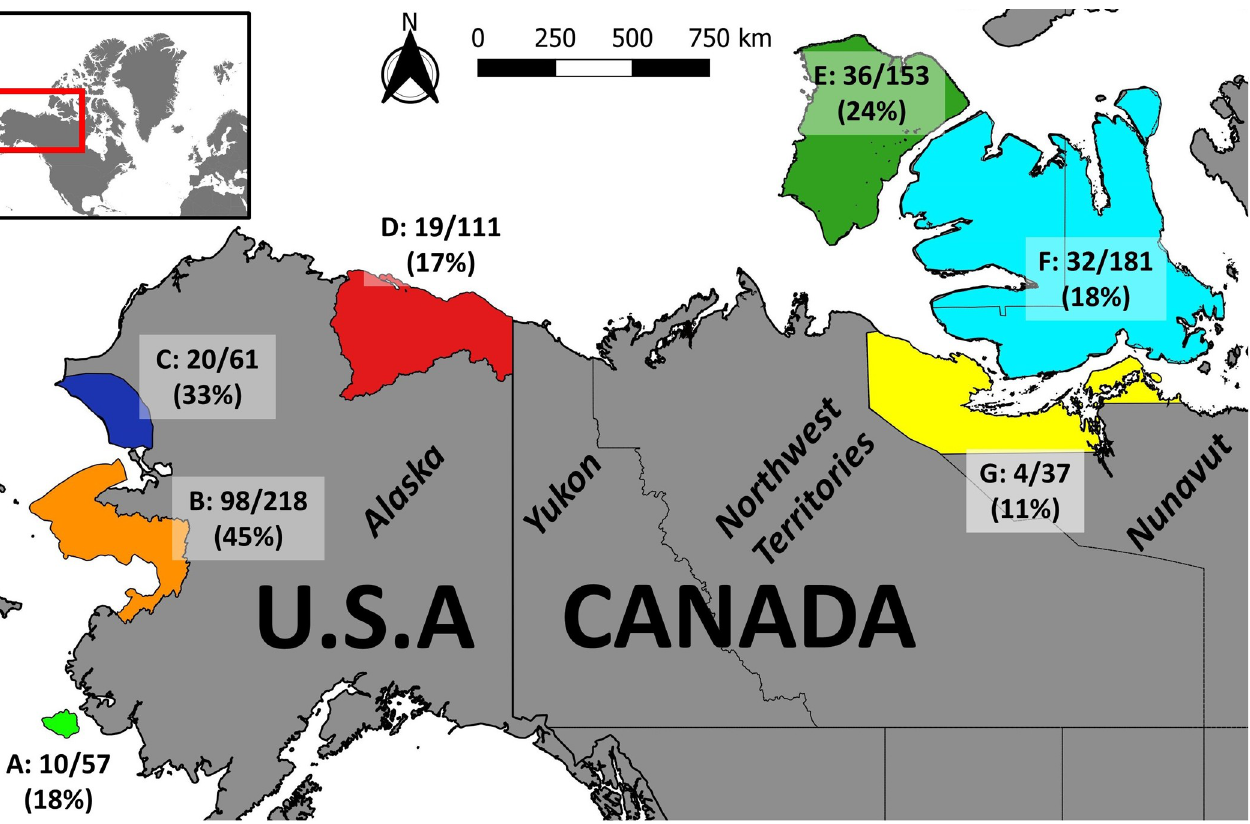
Fig 1. Study area and origin of samples. Regions of origin of 818 muskoxen sampled between 1976 and 2017 and serologically tested for exposure to Erysipelothrix rhusiopathiae . For each region, the number of seropositive/number of tested individuals and the percentage of positives are indicated. A: Nunivak Island; B: Game Management Unit (GMU) 22; C: GMU 23; D: GMU 26; E: Banks Island; F: Victoria Island; G: Kitikmeot Mainland. The map was created using country and province boundaries from